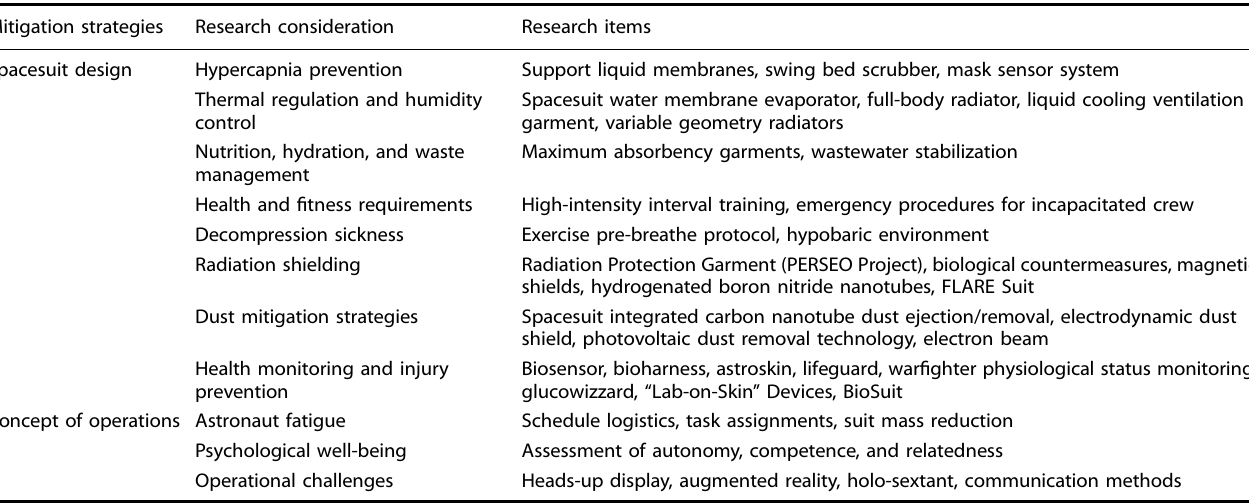
Table 1. Summary of research considerations and associated research